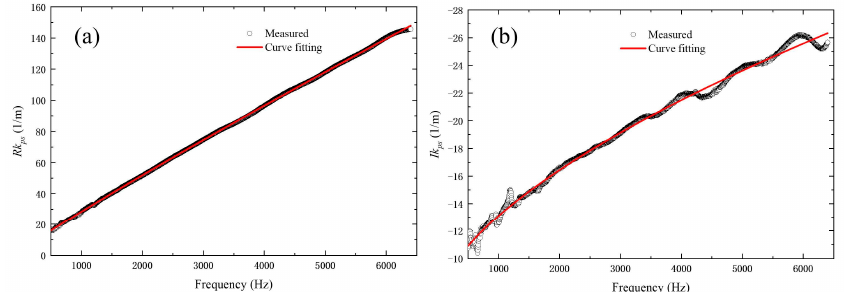
Figure 4. Measured results and curve fitting results of the characteristic impedance of OFC2: ( a ) Real part of measured results and curve fitting results of the characteristic impedance ( 𝑅𝑍 (cid:3043)(cid:3046) = −1.11 × 𝑓 (cid:2868).(cid:2873)(cid:2876)(cid:2873)(cid:2877) + 655.1 ); ( b ) Imaginary part of measured results and curve fitting results of the char- acteristic impedance ( 𝐼𝑍 (cid:3043)(cid:3046) = 𝑖 × (−8794 × 𝑓 (cid:2879)(cid:2868).(cid:2873)(cid:2874)(cid:2868)(cid:2877) + 50.17) ).